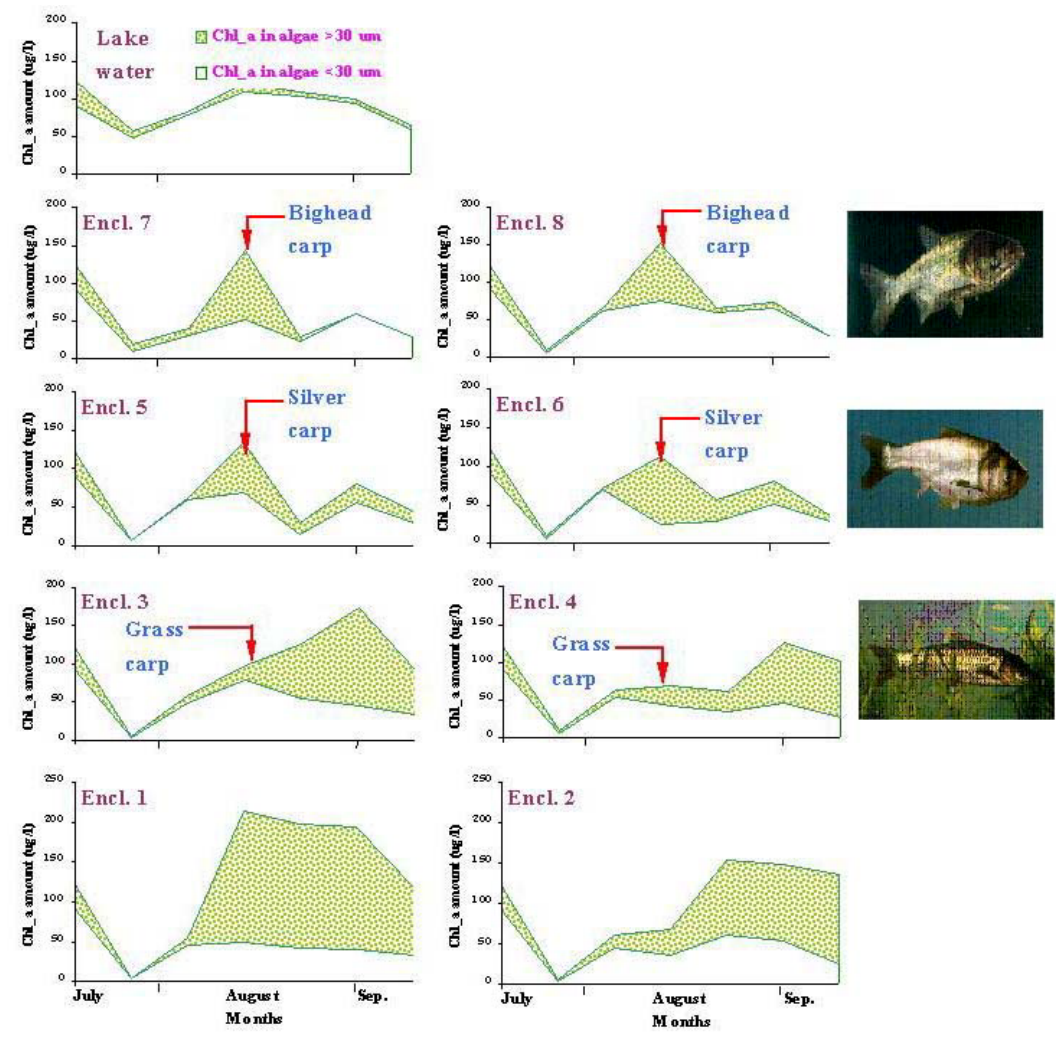
FIGURE 11. Changes in chlorophyll a amount in both total phytoplankton and those <30 µ m phytoplankton in enclosures and the surrounding lake water in Lake Donghu during July–September, 1992 (adapted from Xie et al.[16]).